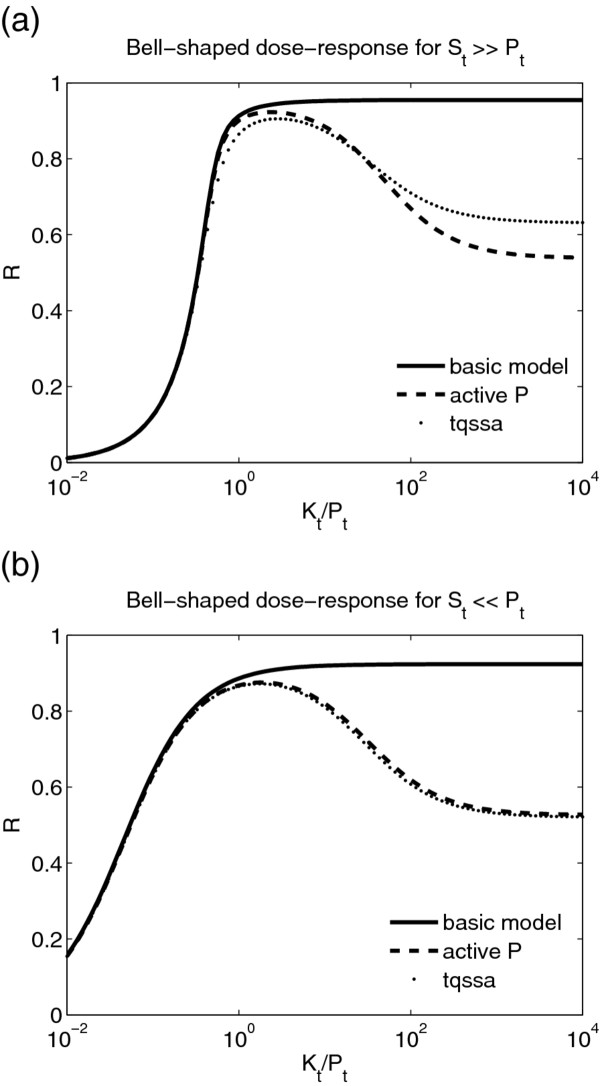
Bell-shaped dose-response in the active phosphatase case (Figure2c). (a) Bell-shaped response in the zero-order regime when St ≫ Pt. Parameters used are: λ−1 = 10 s−1,λ1 = 1μM−1s−1, k1 = 1 s−1,λ−2 = 10 s−1,λ2 = 20μM−1s−1,k2 =1 s−1,λ−3 = 10 s−1,λ3 = 1μM−1s−1,k3 = 100cs−1,κ−1 = 50 s−1,κ1 = 1μM−1s−1,Pt = 1μM,St = 10μM. The Hill coefficient for the basic model is nH = 2.15. (b) Bell-shaped response outside the zero-order regime when St ≪ Pt: λ−1 =10 s−1,λ1 = 1μM−1s−1,k1 = 1 s−1,λ− 2= 10 s−1,λ2 = 20μM−1s−1,k2 = 1 s−1,λ−3 = 10 s−1,λ3 = 1μM−1s−1,k3 = 100 s−1,κ−1 = 50 s−1,κ1 = 1μM−1s−1,Pt = 1μM,St = 0.1μM. The Hill coefficient for the basic model is nH = 1. In (a)-(b), the full line corresponds to the basic model, the dashed line is numerical results for the extended model and the dotted line shows the tQSSA approximation.